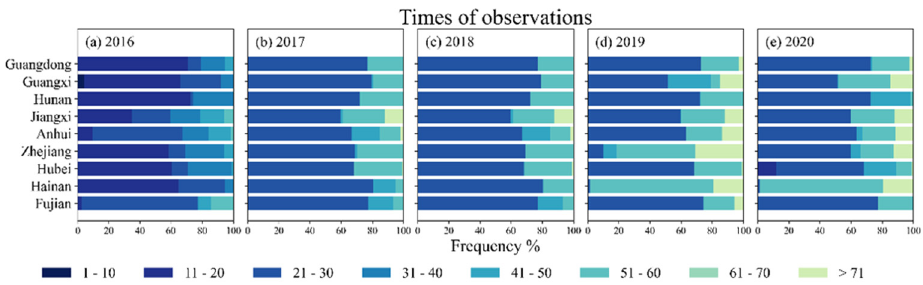
Figure 10. Times of Sentinel-1 original observations from February to December during 2016 ( a ) to 2020 ( e ).